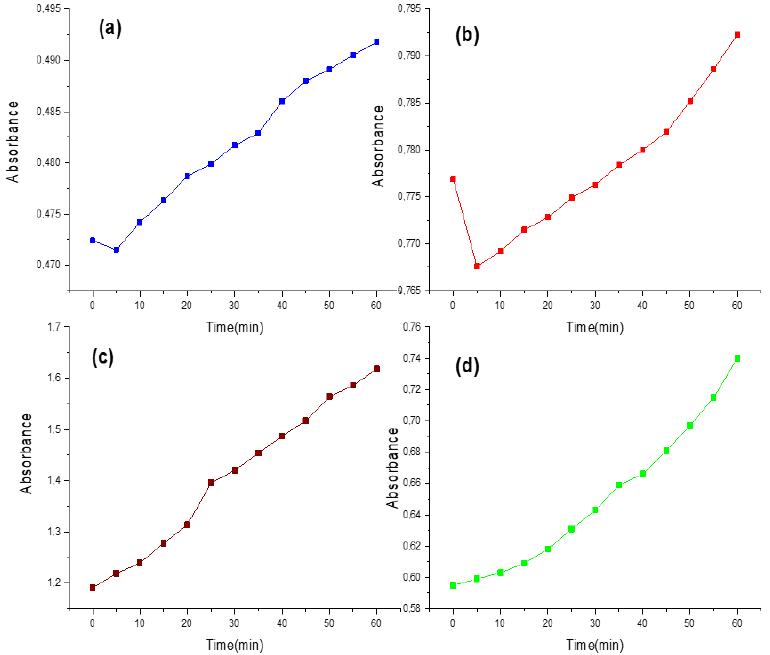
Figure 4. Absorption reading at 390 nm accompanying the [(Cl) 2 Mn(RCOOET)]-catalyzed oxidation of catechol to o-quinone, ( a ) [(Cl) 2 Mn(RCOOET)] formed in situ in MeOH, ( b ) pre- synthesized [(Cl) 2 Mn(RCOOET)] in MeOH, ( c ) pre-synthesized [(Cl) 2 Mn(RCOOET)] in THF and ( d ) [(Cl) 2 Mn(RCOOET)] formed in situ in